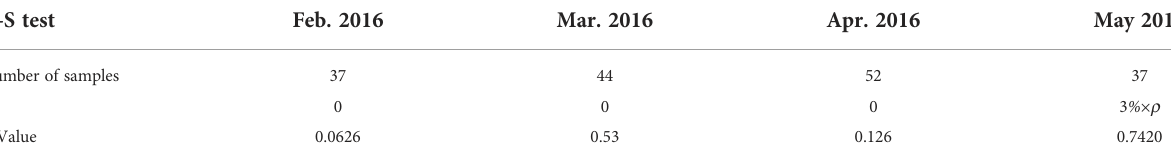
TABLE 1 From February to May 2016, the p-values corresponding to k values of the four groups of data and test values at the signi fi cance level a = 0.05 are shown in Table 1. K-S test